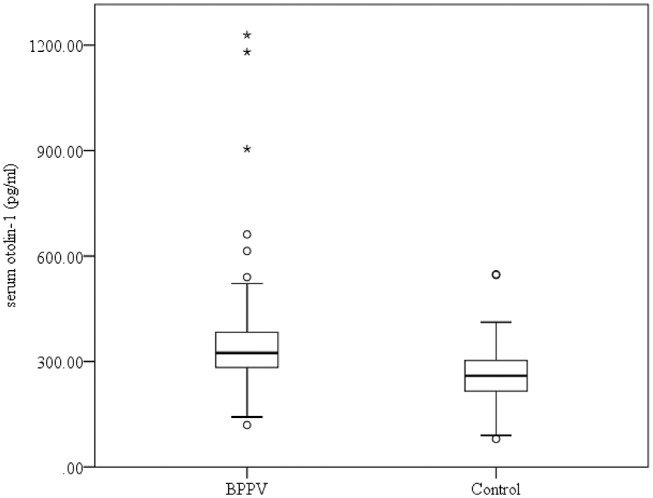
Comparison of serum otolin-1 levels in subjects with BPPV and healthy controls.